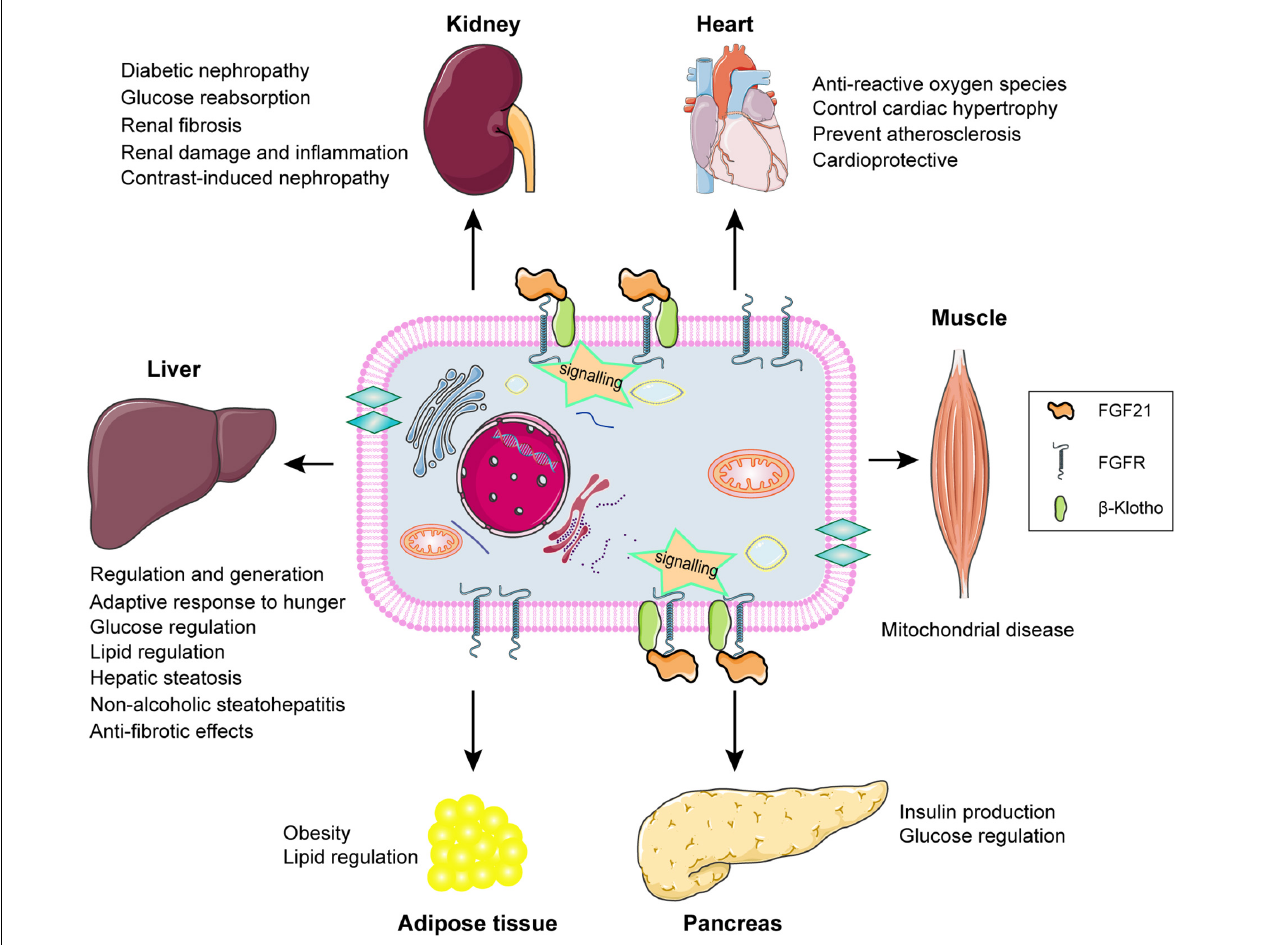
FIGURE 3 | Schematic diagram of FGF21 signaling and the potential biological role of FGF21 in different types of tissue. FGF21 exerts potential biological roles in target organs, including liver, kidney, heart, muscle, pancreas, and adipose tissue, through binding to the β Klotho-FGFR complex achieving the signal transduction.